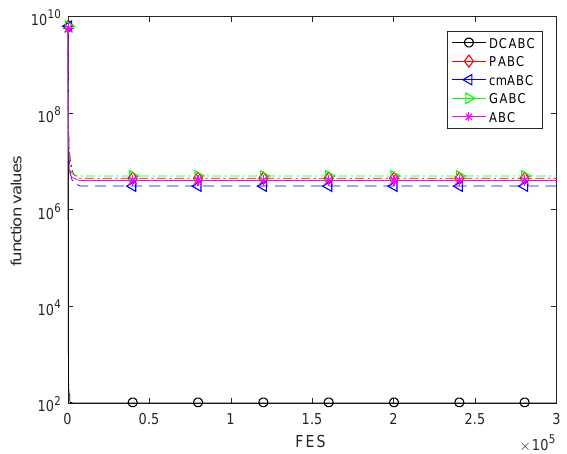
Figure 3. Convergence curves of five algorithms for f 1 with D = 30. (The optimal value of f 1 is 100).